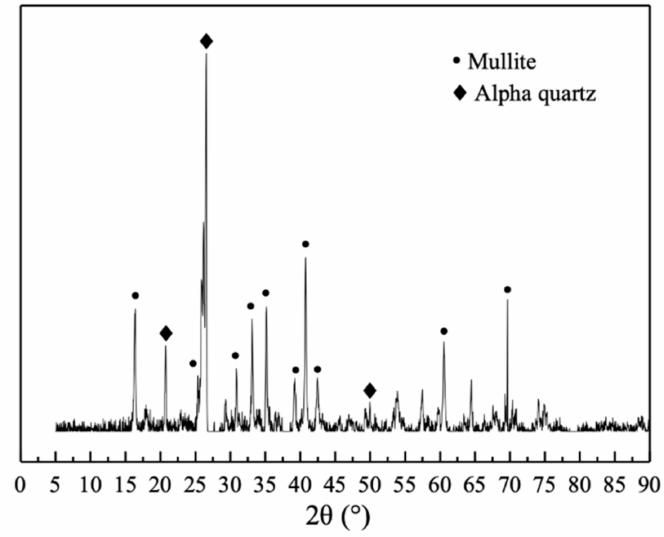
Figure 4. XRD pattern of fly ash.